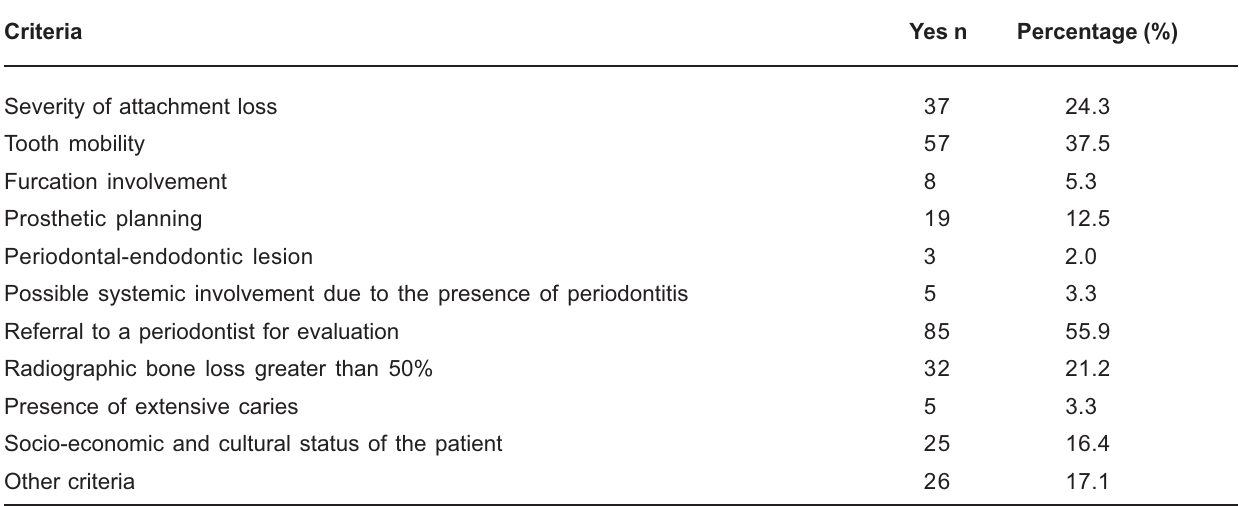
TABLE 2- Criteria adopted by the dentists to indicate the extraction of teeth with periodontitis